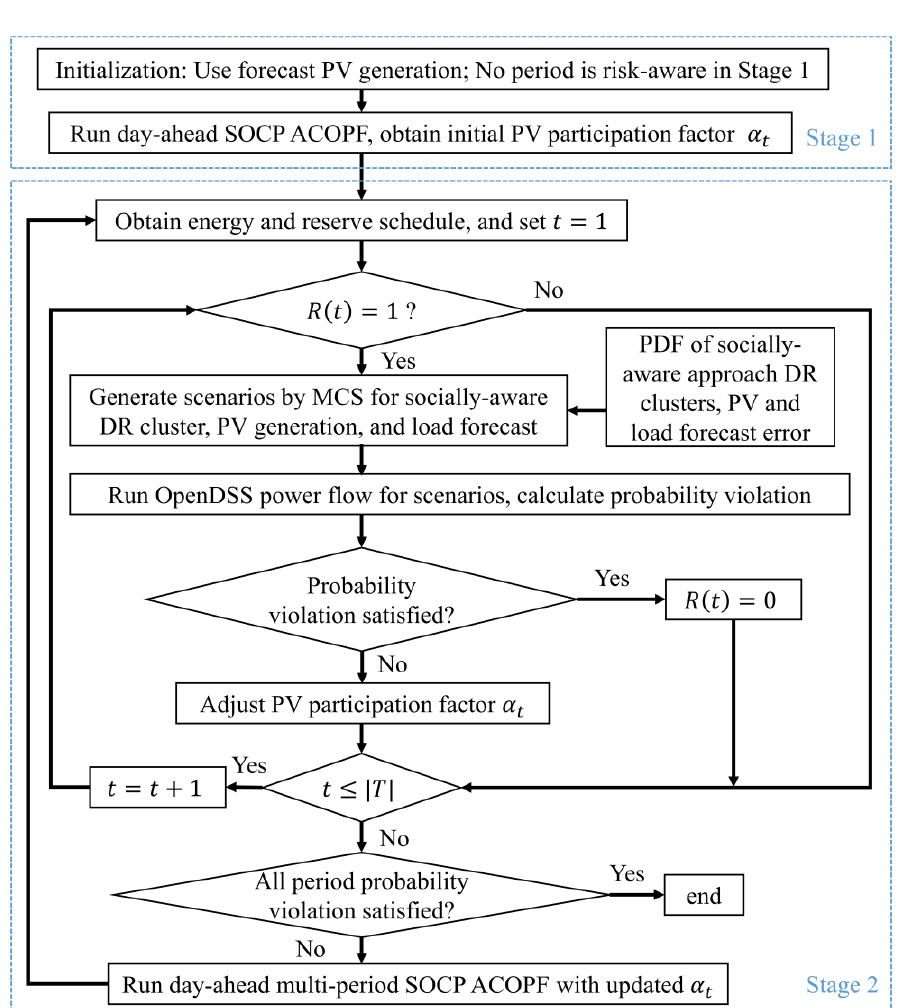
Figure 3. Two-stage flowchart of proposed risk-aware and socially aware algorithm.